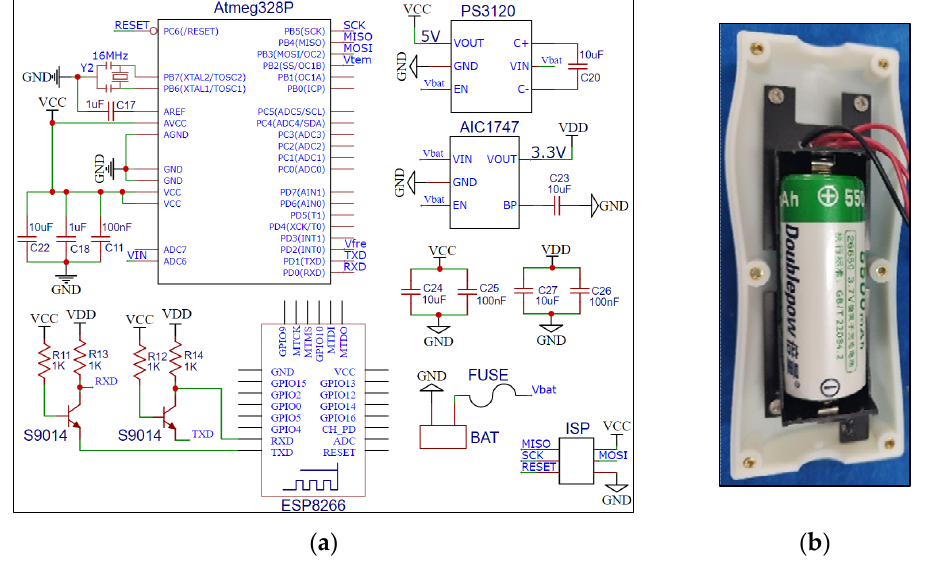
Figure 7. Hardware circuit of data processing module. ( a ) Circuit schematic; ( b ) PCB and physical drawings.